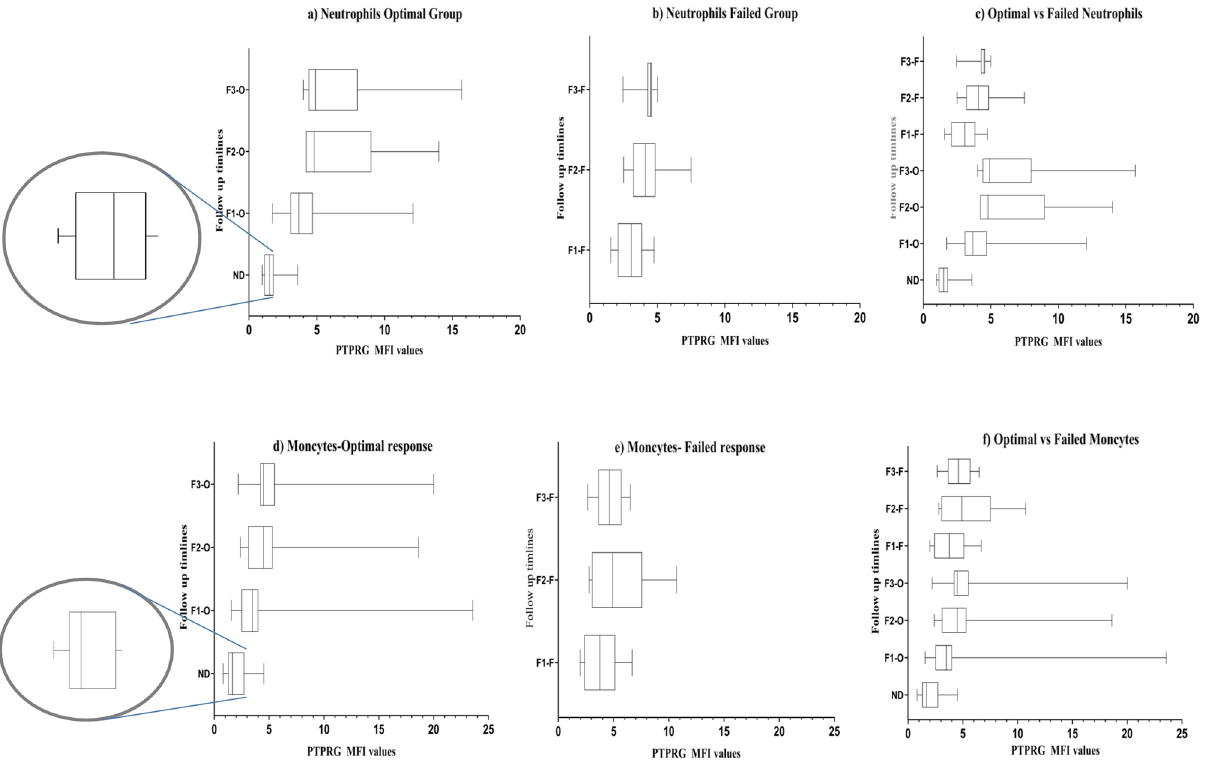
Figure 5. PTPRG protein expressions upon stratification of CML patients’ response in white blood cells and its sub-population. PTPRG level on neutrophils at diagnosis showed a median of 1.50 with negative skewness. ( a ) The restoration level of PTPRG on neutrophils of the optimal response group was greater in follow up periods compared to diagnosis phase, median Follow-up 1 = 3.68; median Follow-up 2 = 4.8; median of Follow-up 3 = 4.9. Histogram showed positive skewness for later follow up periods. ( b ) PTPRG expression on neutrophils of failed response increased significantly by the first follow up compared to the time of diagnosis; median of Follow-up 1 = 3.065; median of Follow-up 2 = 4.0; median of Follow-up 3 = 4.5. Histogram of 1st and 2nd follow- ups showed a normal distribution (Shapiro–Wilk test, W), while the 3rd follow up showed negative skewness.